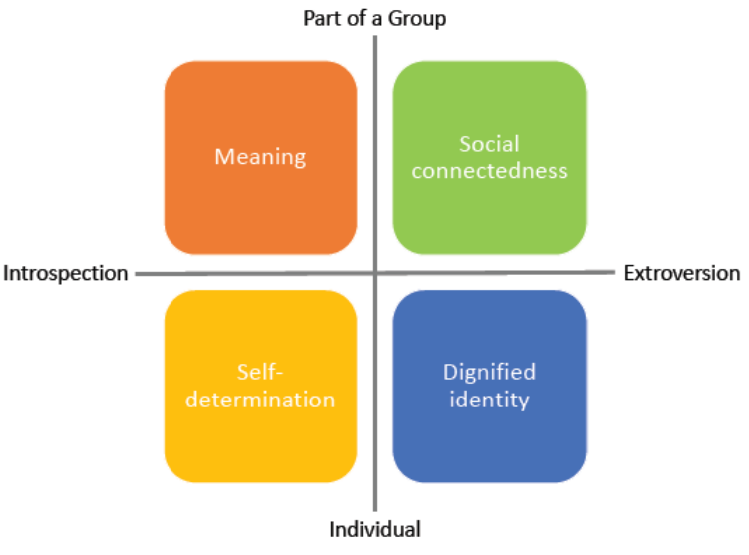
Figure 2. Four domains to assess resilience.